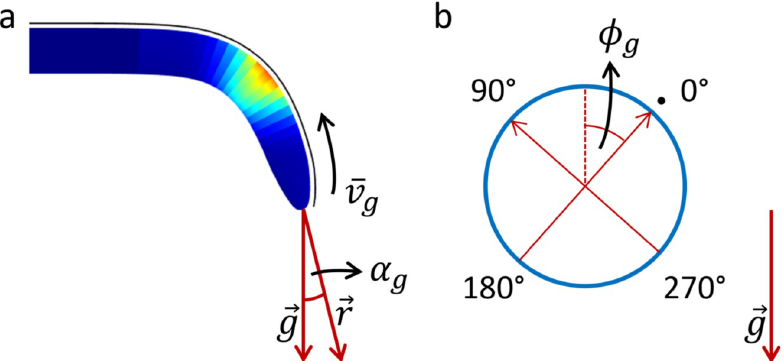
Fig 2. Schematic depicting key parameters under gravitropic signal. (a) A bending root responding to gravity, � ! � ! showing the root tip orientation r ! , the gravity vector g ! , the angle α g gives the deviation of the root from the gravity, and the signal velocity v . (b) A cross-section of the root showing the angle ϕ in the circumference along g g which the maximal signal is propagated. The reference line is drawn in black in (a) and with a black dot in